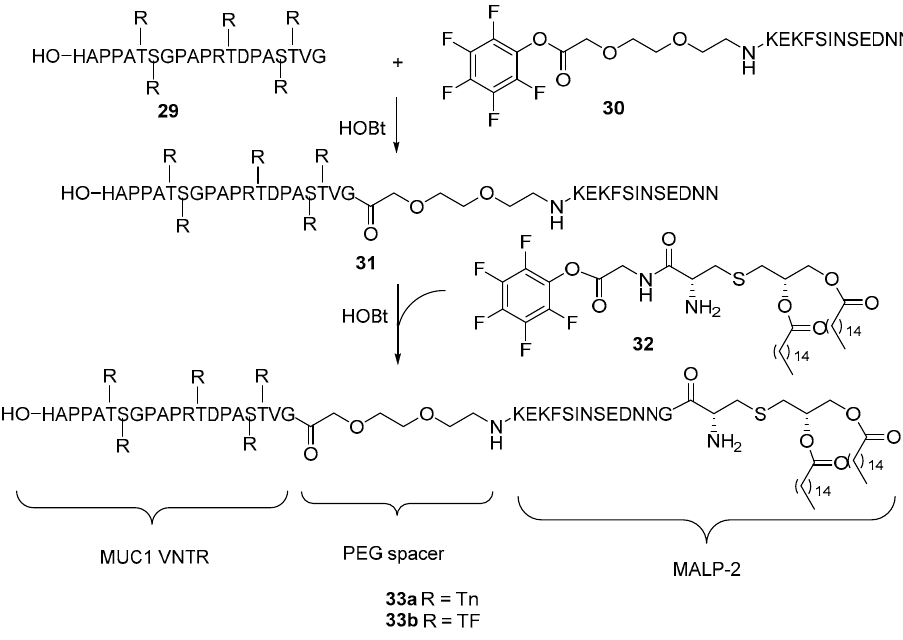
Scheme 7. Synthesis of MUC1 glycopeptide-MALP-2 conjugates 33a and 33b as vaccine